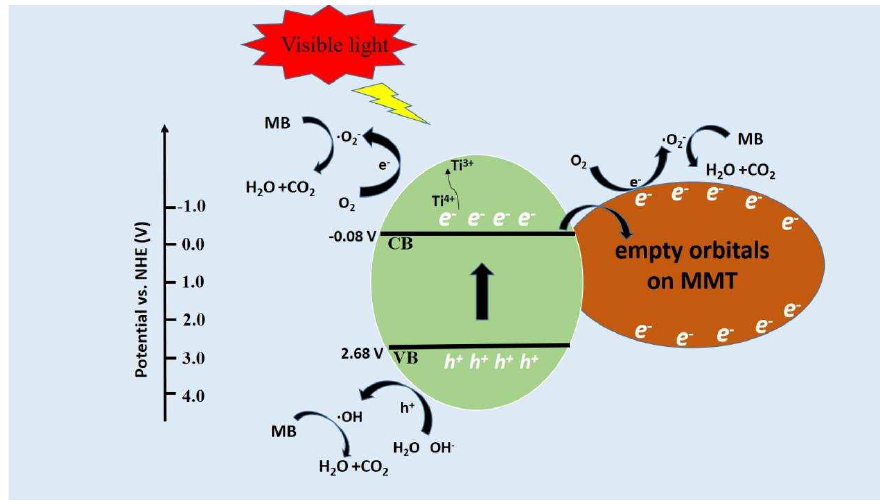
Figure 16. Suggested mechanism of methylene blue (MB) photodegradation by 30%-TM. Compared with TiO 2 , the number of oxygen vacancies in the composites increased markedly, indicating that it was easier to generate oxygen vacancies on the MMT’s surface supported by TiO 2 . These changes could be attributed to the combination of the Si–O bond (in the Si–O tetrahedron on the MMT’s surface) and the TiO 2 hydrosol that formed the Si– O–Ti bond [19,54]. Cheng et al. reported that oxygen vacancies and Ti 3+ content affected the band gap of TiO 2 matrix composites [19,54,56,57]. Thus, the changes in the band gap of TiO 2 matrix composites is mainly related to the number of oxygen vacancies and the content of Ti 3+ in the material. In TiO 2 –MMT composites, TiO 2 acts as a photocatalyst, pro- ducing electrons ( e − ) and holes ( h + ) under illumination. The electrons pass through the band gap and then enter the CB, leaving holes in the VB [58]. Compared with pure TiO 2 , composites with MMT featured lower band gaps, thus favoring the injection of electrons into the CB. In the composite of TiO 2 and MMT, the electrons in the CB react with Ti 4+ to form Ti 3+ , which is considered the most reactive site in the oxidation process because it can produce more oxygen vacancies to facilitate the adsorption of O 2 on the TiO 2 ’s surface [59]. The adsorbed O 2 molecules then react with electrons to produce highly reactive · O 2−